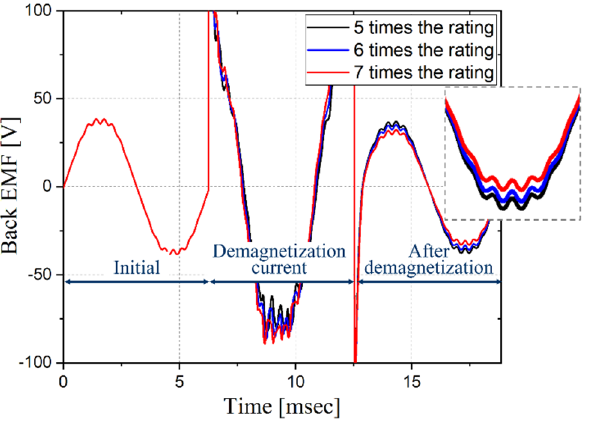
Figure 4. Back electromotive force (EMF) waveforms after the demagnetization.